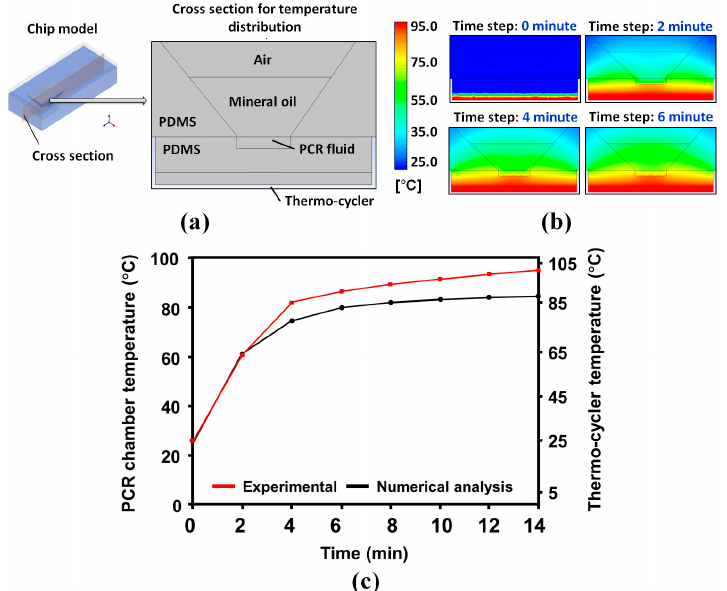
Figure 2. Heat-transfer profiles in the μ FPNAS. ( a ) A cross section image of the μ FPNAS. ( b ) Figure2. Heat-transferprofilesinthe µ FPNAS.( a )Acrosssectionimageofthe µ FPNAS.( b )Temperature changes in the PCR chamber for 6 min. ( c ) Comparison of experimental and numerical